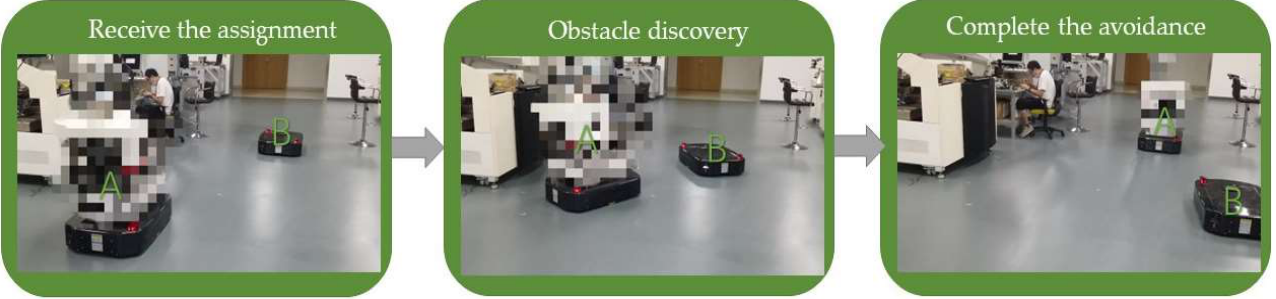
Figure 16. Side avoidance. A and B are the serial numbers of AGVs respectively.